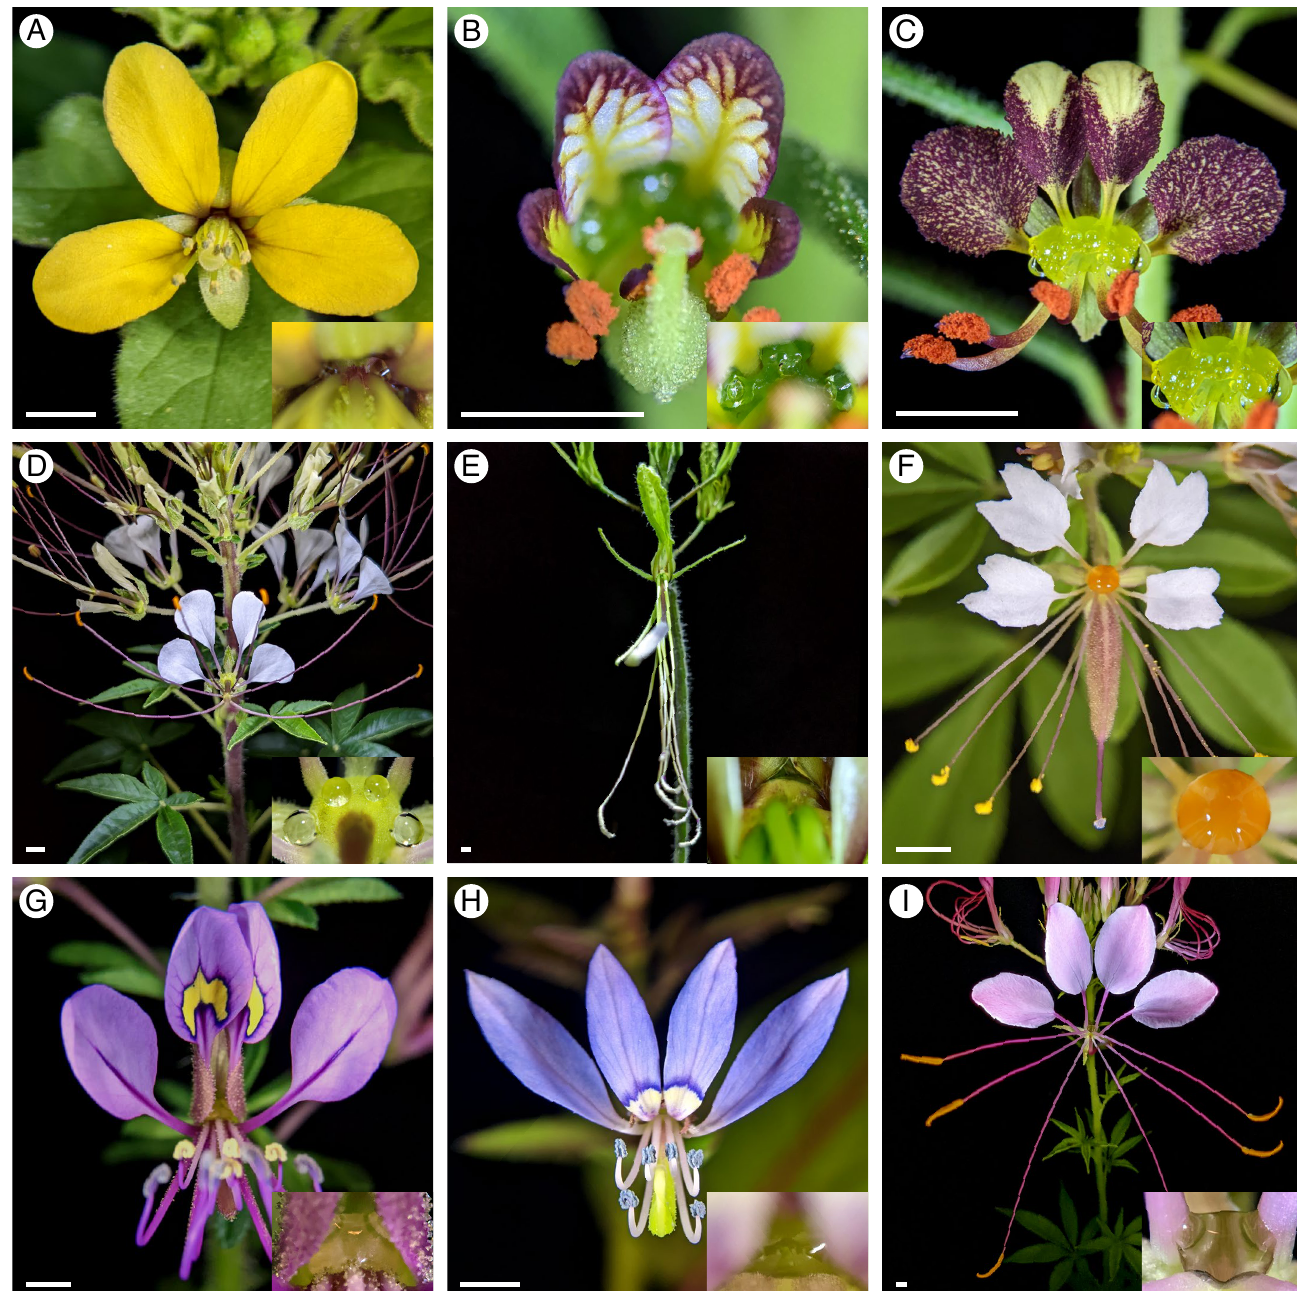
Figure 1. Anthetic flower with nectary inset of the nine Cleomaceae species. ( A ) Arivela viscosa . ( B ) Cleome amblyocarpa . ( C ) Cleome violacea . ( D ) Gynandropsis gynandra . ( E ) Melidiscus giganteus . ( F ) Polanisia dodecandra . ( G ) Sieruela hirta . ( H ) Sieruela rutidosperma . ( I ) Tarenaya houtteana . The scale bar represents 0.25 cm in all images to illustrate the drastic variation in flower